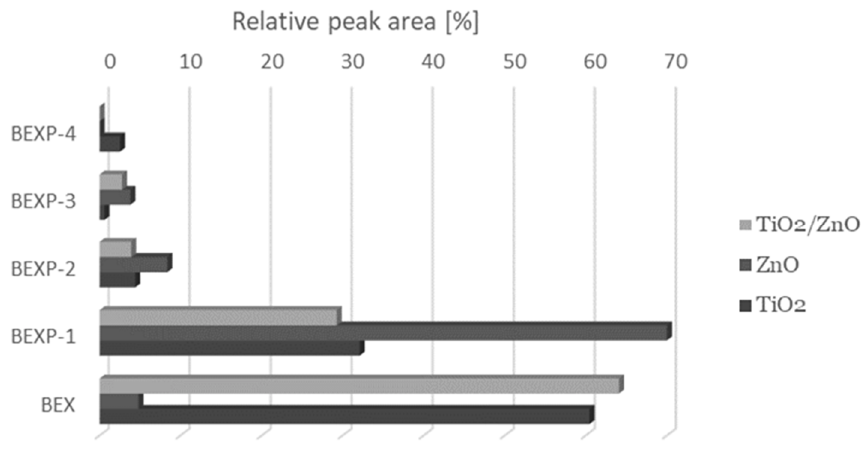
Figure 3. Average relative peak areas of the main photodegradation products of bexarotene after 30 min of UV irradiation evaluated with the UPLC-MS/MS technique. 30 min of UV irradiation evaluated with the UPLC-MS/MS